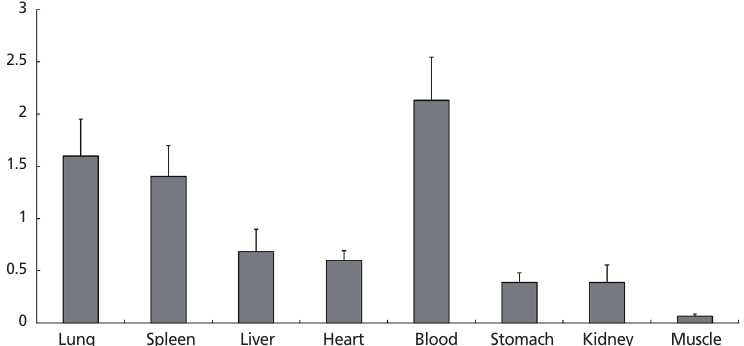
Lung BloodSpleen StomachLiver Figure 1. Relative quantification of expression levels of porcine GYPC mRNA in eight different tissues. Bars represent the mean±standard error (n = 3). The values were normalized to internal GAPDH expression. GYPC, glycophorin C; GAPDH, glyceraldehyde-3-phosphate dehydrogenase. Table 2. Genotype frequencies and allelic frequencies of GYPC gene determined by MALDI-TOF-MS in three pig populations Breed Number